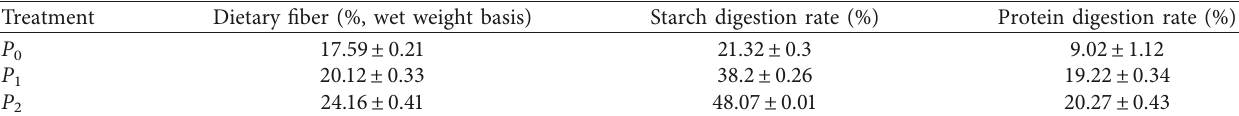
Table 6: Cookies with tempeh gembus flour substitution’s dietary fiber, starch digestion, and protein digestion rate.